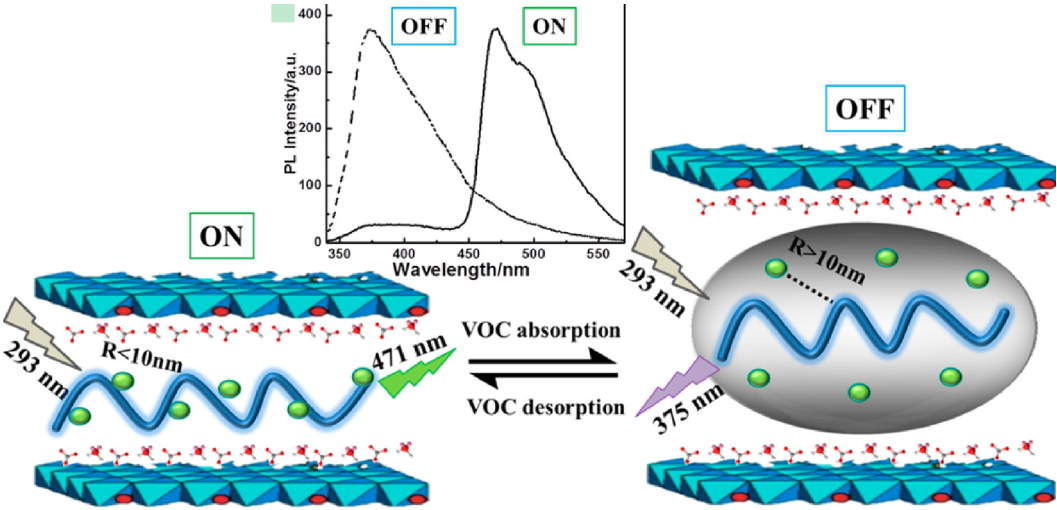
Figure 13. LBL assembling of the poly(N-vinylcarbazole) (PVK) and Ir(F 2 ppy) 3 between LDH nanosheets. Föster resonance energy transfer (FRET) process between PVK and Ir(F 2 ppy) 3 interrupted by VOC vapors. Fluorescence spectra in the atmosphere (black) and in toluene vapor (red) excited at 294 nm. Reprinted with permission from Qin et al. [90]. Copyright American Chemical Society